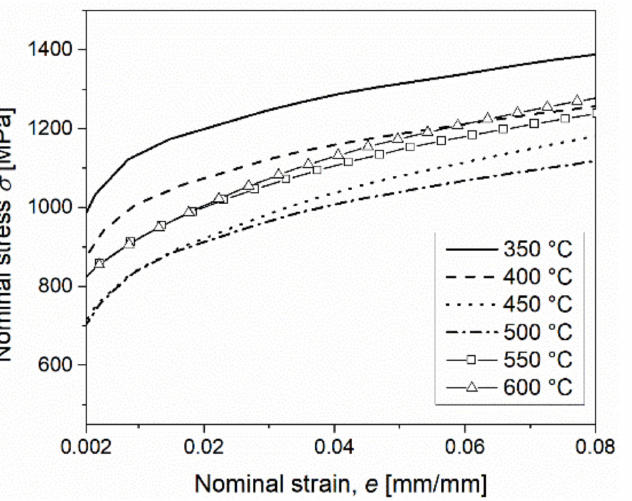
Figure 7. Compressive stress–strain curves for the Ti-V steel samples isothermally heat treated at different temperatures in the range from 350 ◦ C to 600 ◦ C for 1200 s and subsequently quenched in oil.